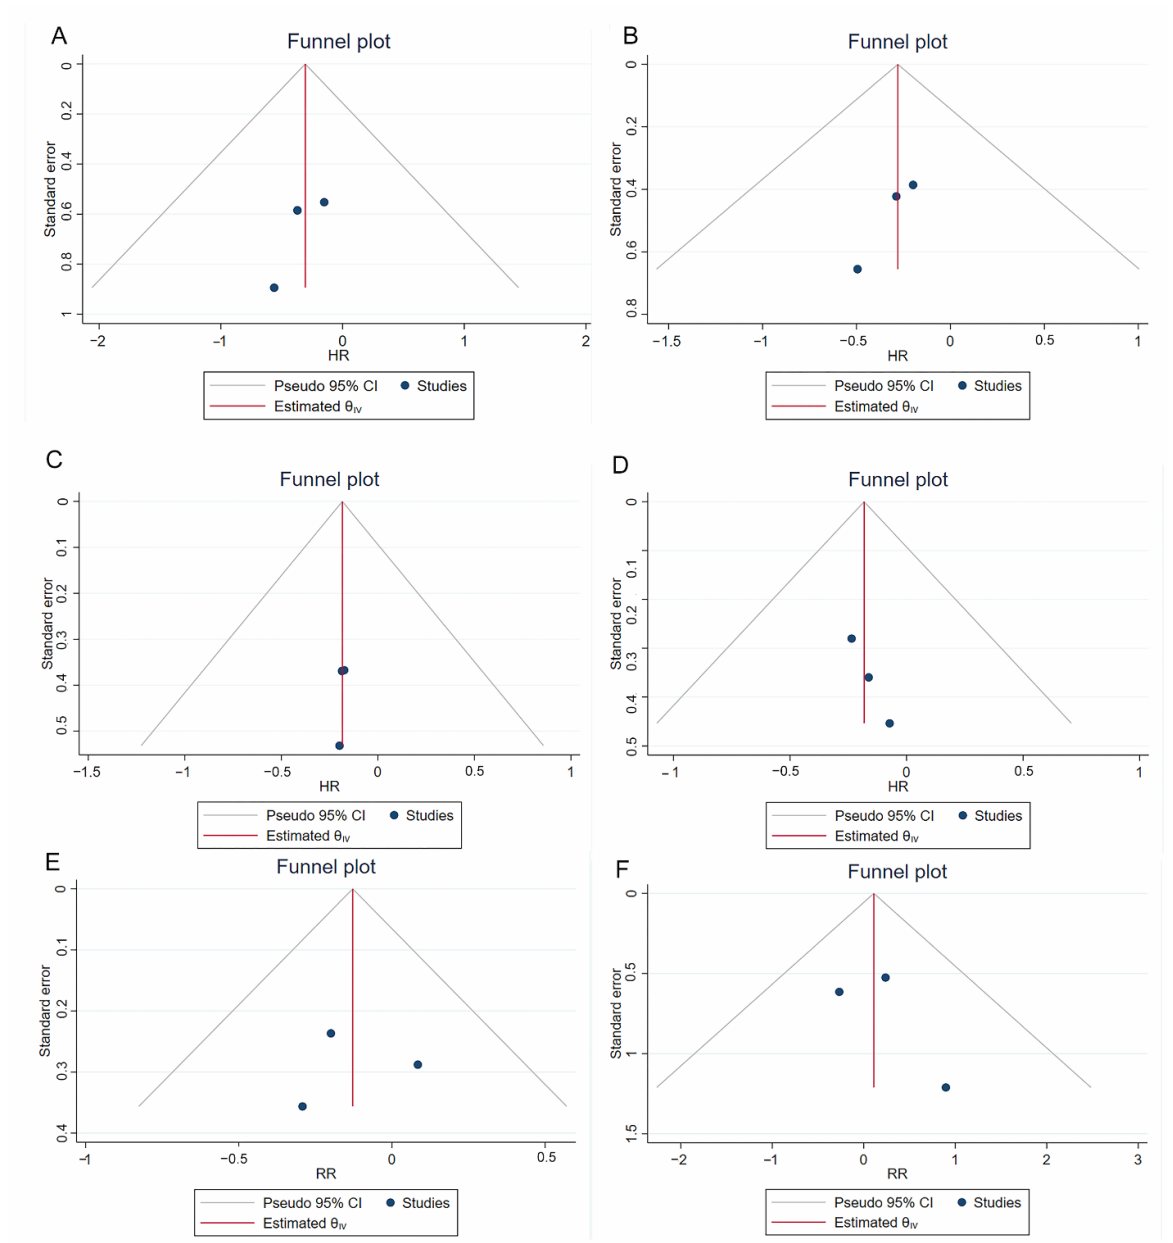
Figure 6. Funnel plots of comparisons 1-year RFS ( A ), 2-year RFS ( B ), 3-year RFS ( C ), 5-year RFS ( D ), recurrence ( E ) and progression ( F ) between reTURB group and control group. CI: confidence